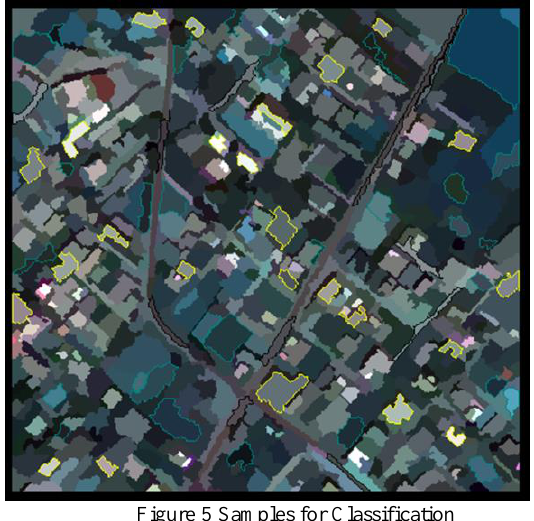
Figure 4 Segmented Image using Multi-resolution algorithm